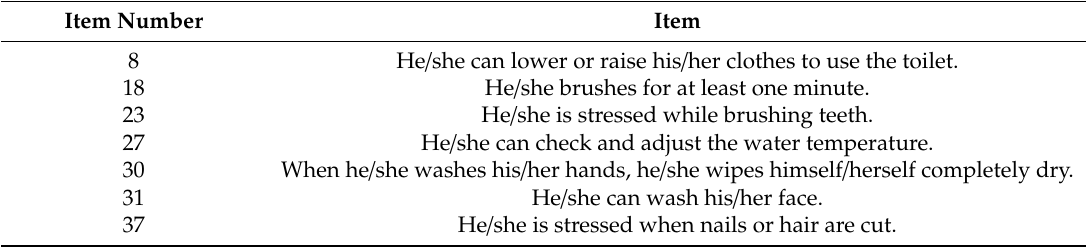
Table 8. Deleted items from the Personal Hygiene scale.